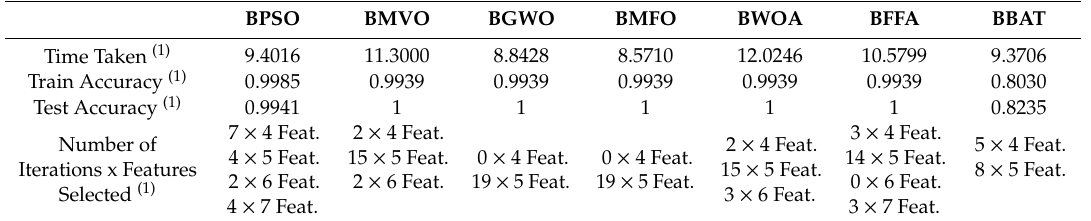
Table 4. Feature selection optimization results.